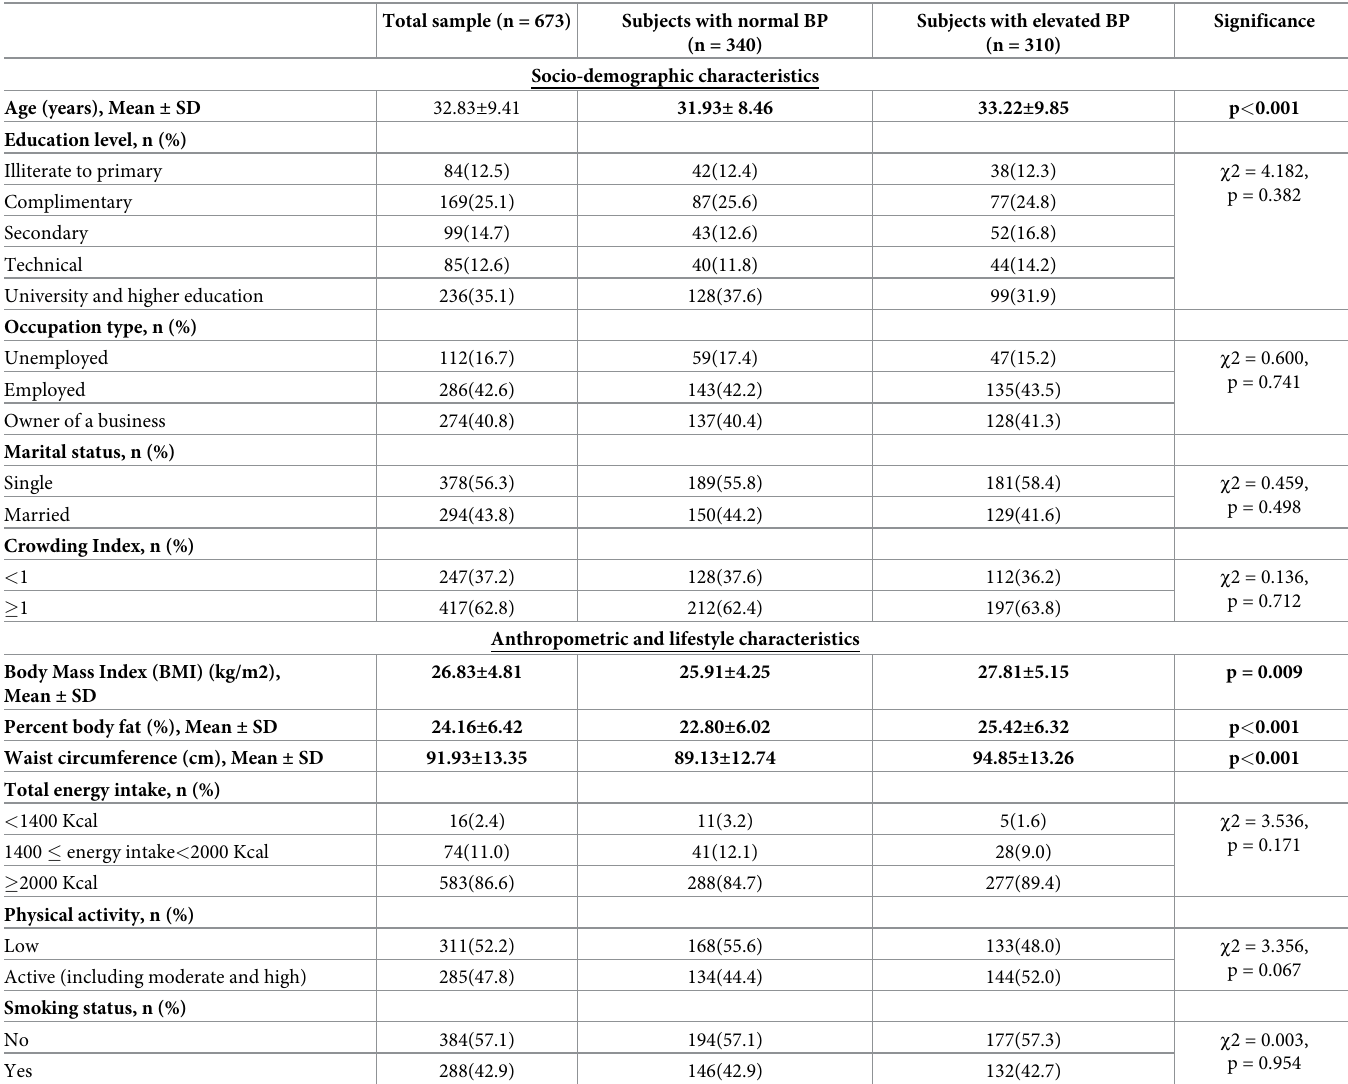
Table 1. Socio-demographic, anthropometric and lifestyle characteristics of study participants (n =